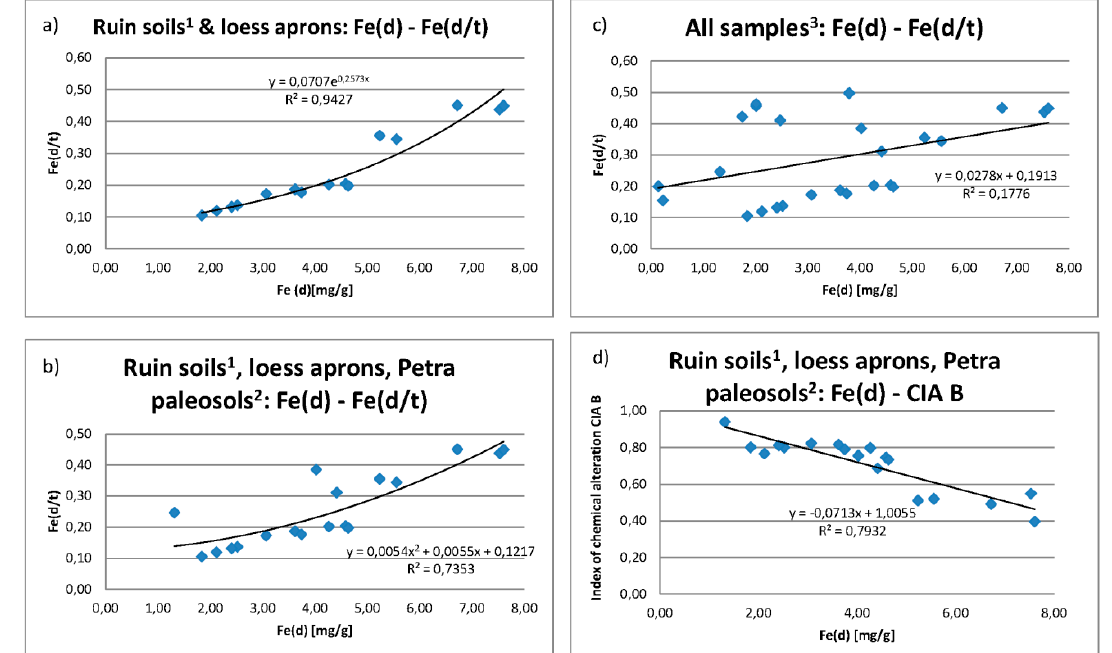
Figure 10. ( a ) Ratio of dithionite-extractable iron Fe(d) to dithionite-extractable to total iron Fe(d/t) for the ruin soils and loessial aprons in the Negev; ( b ) also including the paleosols in the Petra region; ( c ) including the reference samples as well. ( d ) Correlation of Fe(d) and the Index of Chemical Alteration (CIA) B.